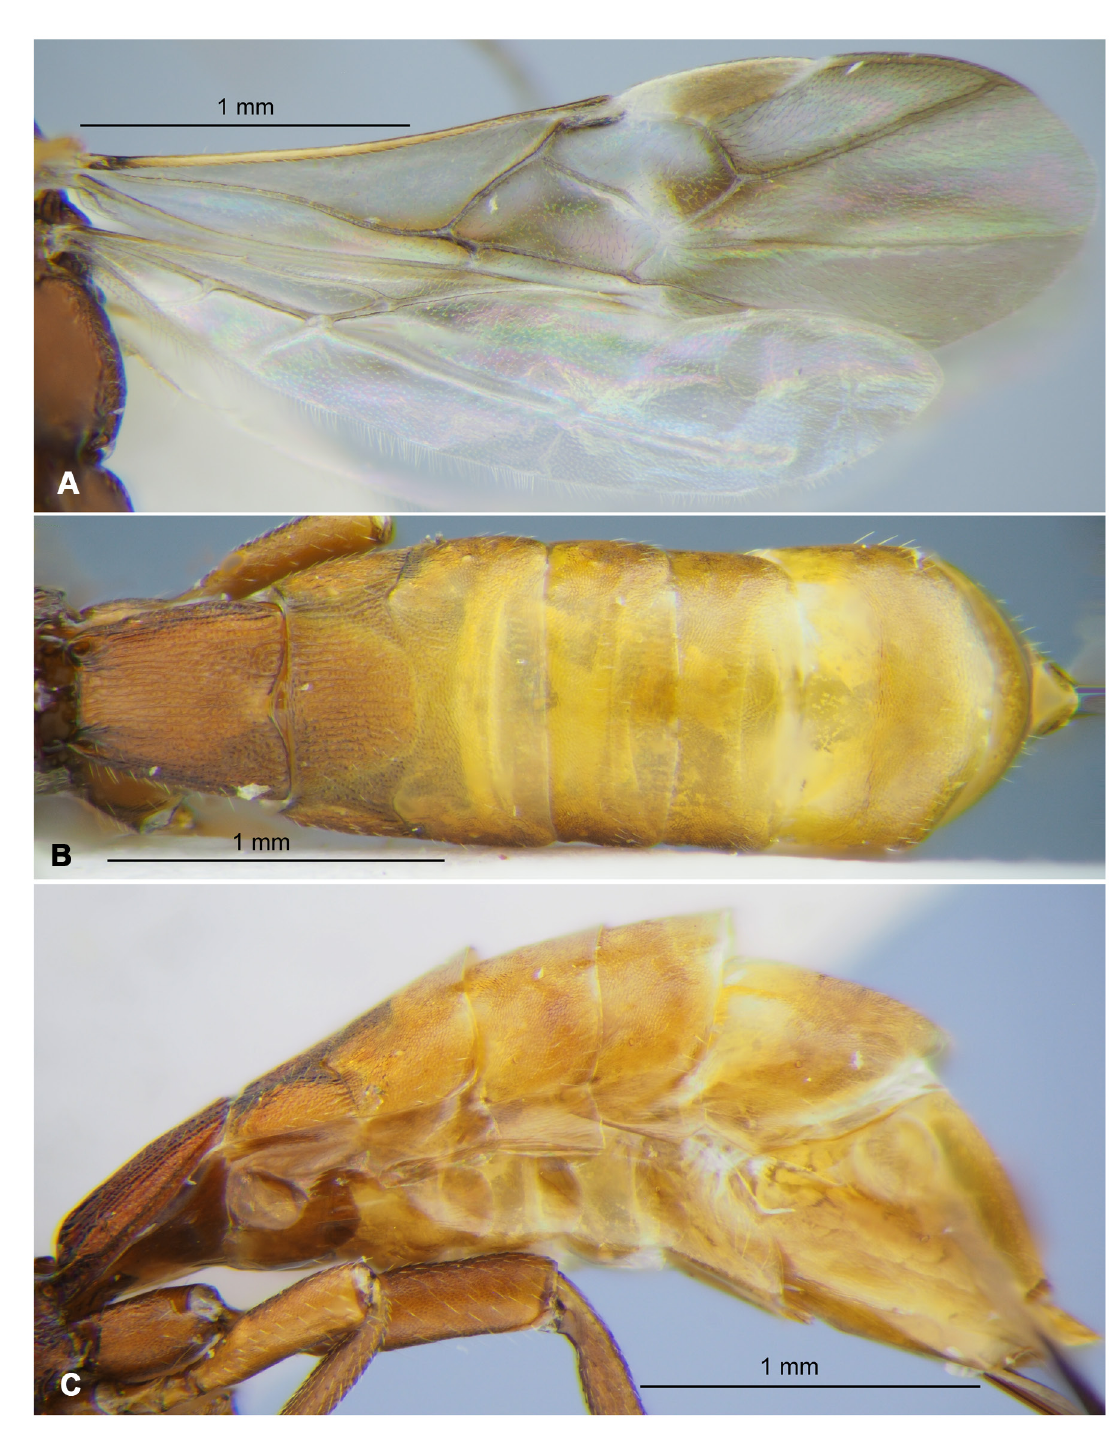
Fig. 27. Hecabalodes anthaxiae Wilkinson, 1929, ♀ (RMNH). A . Wings. B . Metasoma, dorsal view. C . Metasoma, lateral